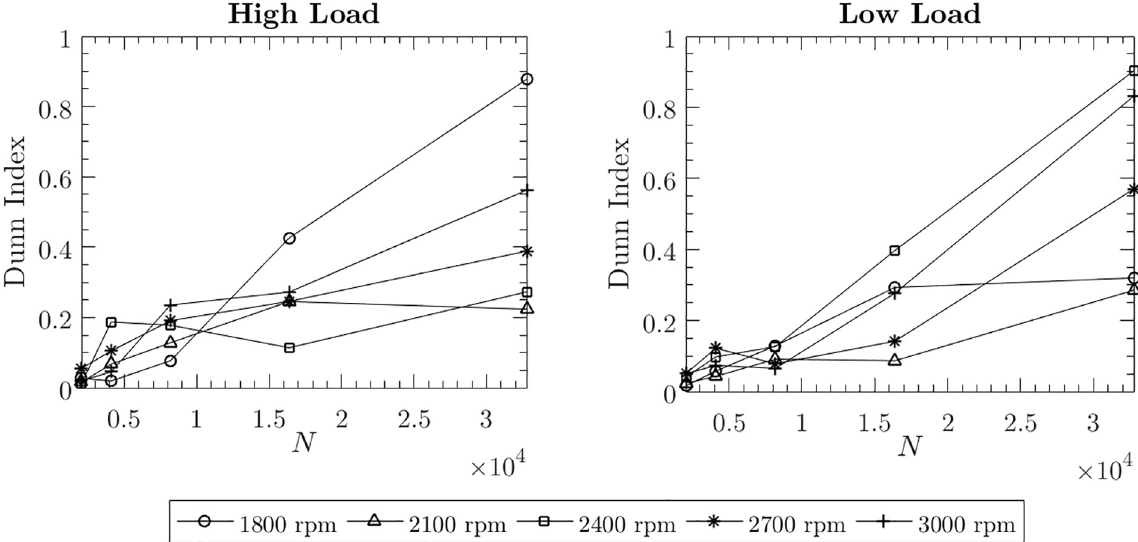
Fig 9. Variation of Dunn Index values with respect to varying signal length. N takes values 2048, 4096, 8192, 16384, and 32768. The plots give Dunn Index values for low and high load conditions and different rotational speeds, i.e.30 rps (1800 rpm), 35 rps (2100 rpm), 40 rps (2400 rpm), 45 rps (2700 rpm), and 50 rps (3000